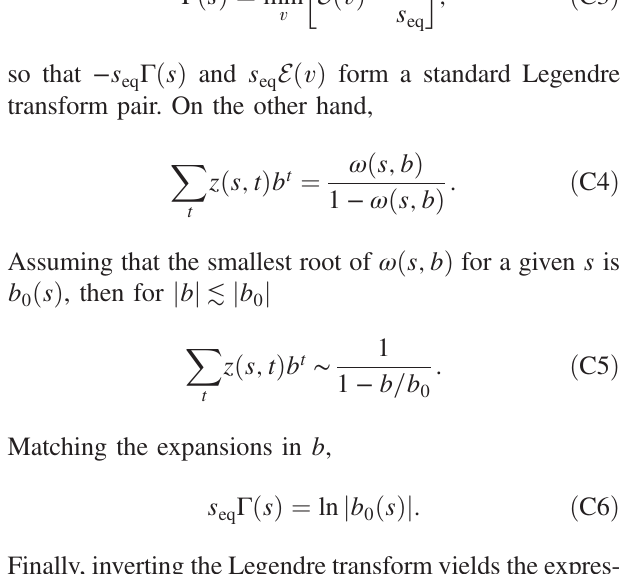
FIG. 20. The decay of j W j and Z at x ¼ 0 , 1 and exp ð − s for (top) reflection symmetric gate in Eq. (72), (center) Floquet Ising model in Eq. (80), and (bottom) dual-unitary gate in Eq. (81).